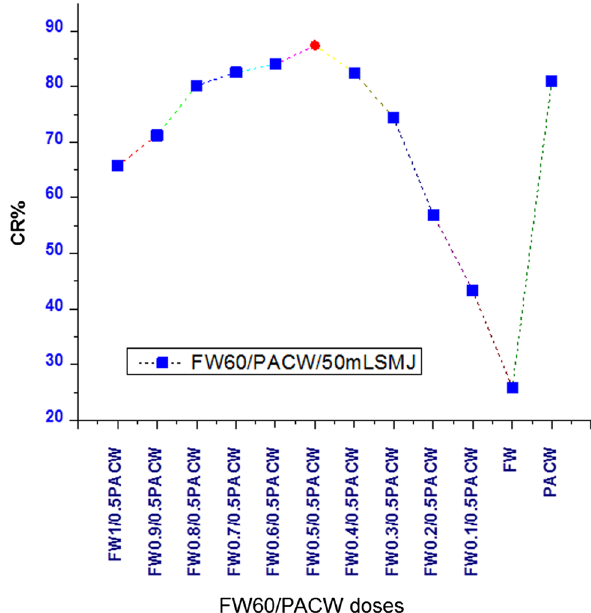
Fig. 8 Effect of FW60 different doses added to PACW